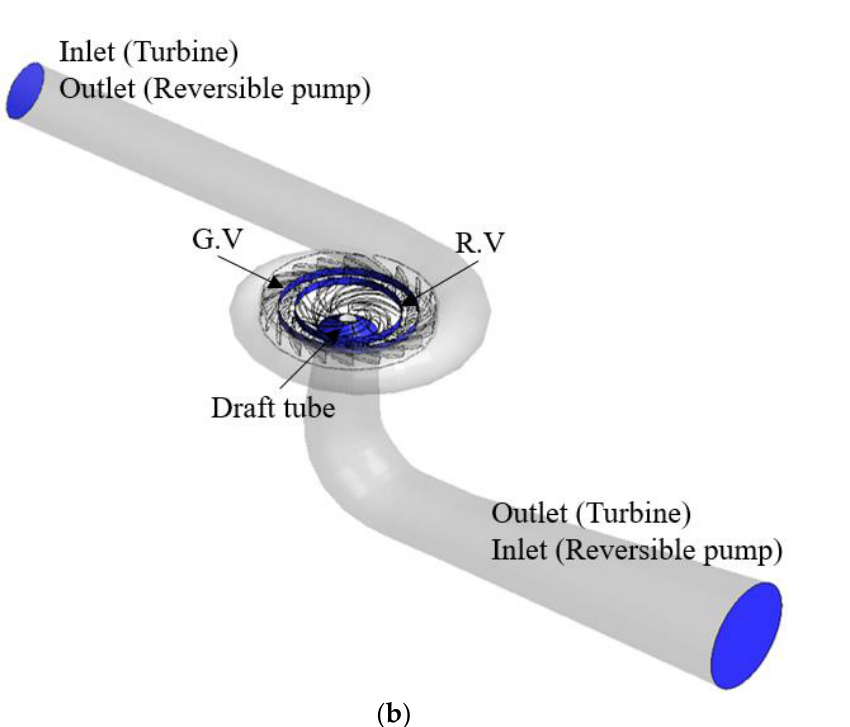
Figure 3. Geometrical structure and computational domain. ( a ) Hybrid (unstructured and structured) grid system. ( b ) Boundary conditions in turbine and pump modes.